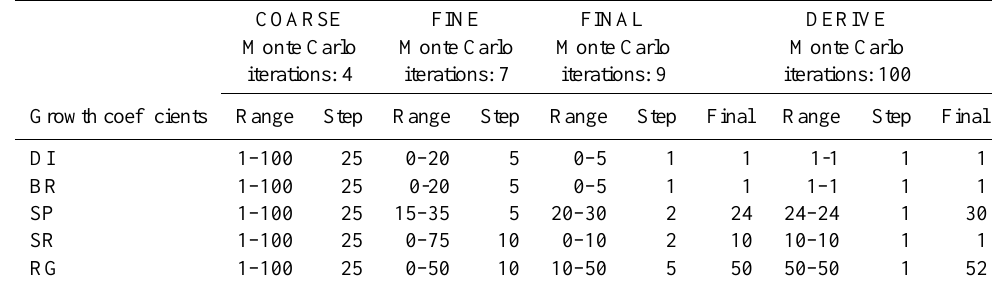
Figure 4. Flow diagram showing the complete methodological procedure. Table 4. SLEUTH calibration parameters for 1978–2011 historic urban growth of the Emilia-Romagna coastal area.